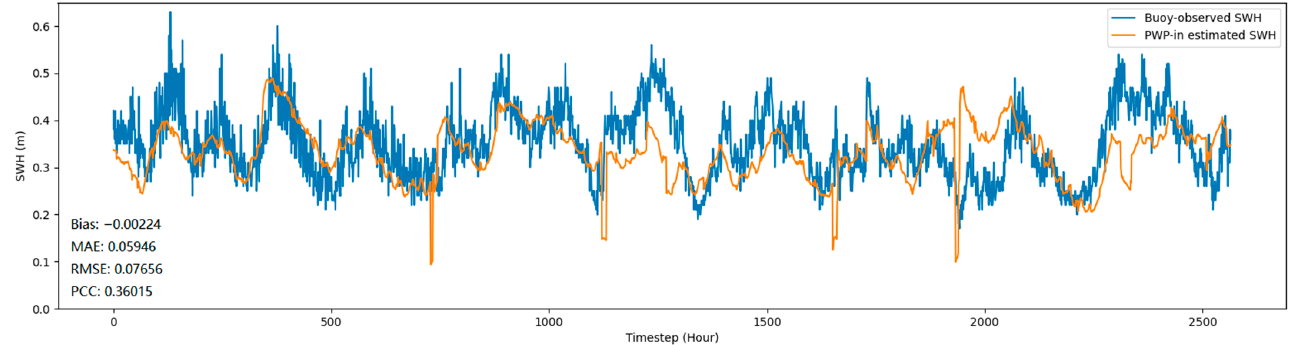
Figure 10. Comparison between the SWH estimation of PWP-in at the buoy location and buoy-observed SWH in the time periods August 2018 and July 2019–September 2019.